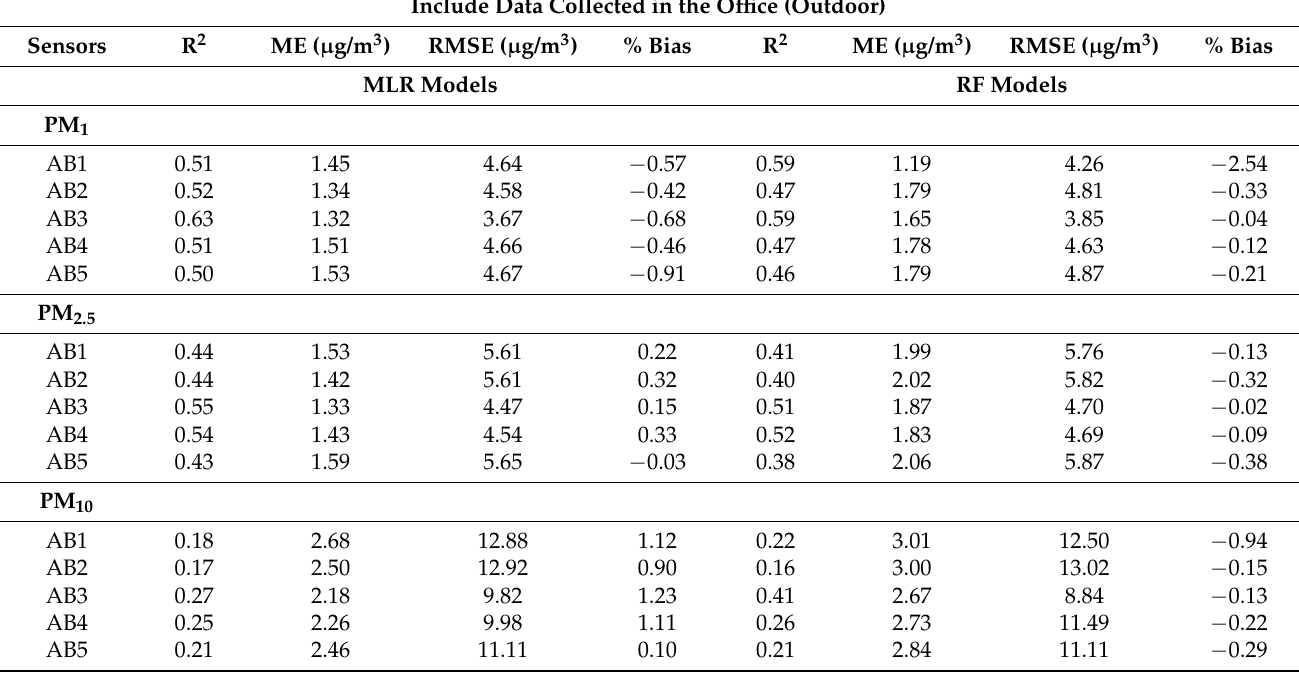
Table 4. Summary of cross-validation R 2 , ME, RMSE, and bias percentage for calibration models based on data collected in all selected environments.